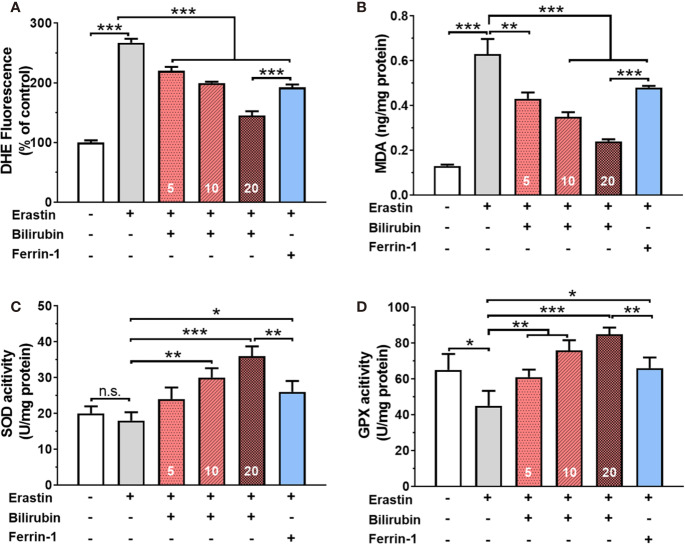
Oxidative stress and antioxidant status in islets after various drug treatments. The ROS levels (A), MDA levels (B), SOD activity (C), and GPX activity (D) of the islets with bilirubin after 50 μM erastin treatment. Islets were pretreated with or without bilirubin for 24 h and then treated with 50 μM erastin for another 24 h. Afterward, the supernatant was collected for the assessment. Data are presented as mean ± SD (n = 3). *P < 0.05, **P < 0.01, and ***P < 0.001.